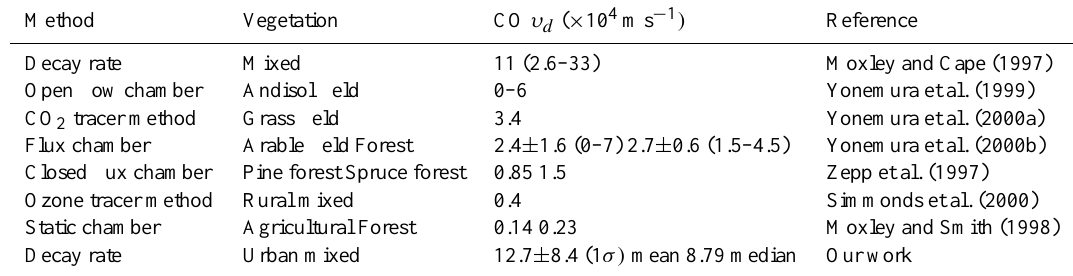
Table 2. Comparison of CO deposition